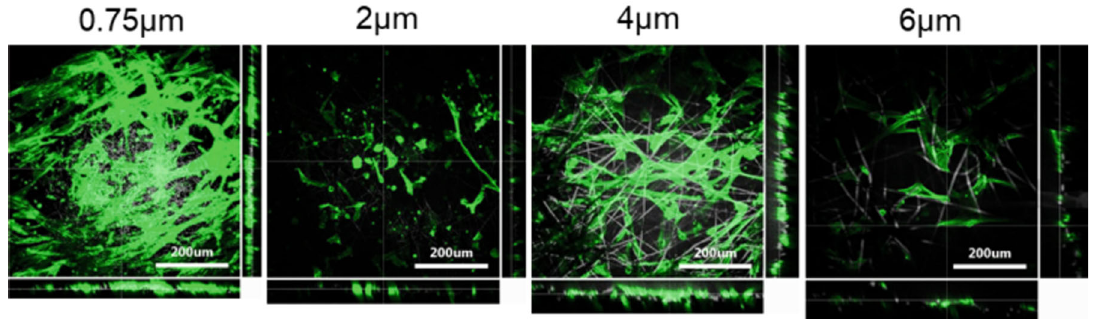
Fig. 4 Z-stack confocal fl uorescence images of actin stained HUVSMCs after 12 days of culture on all four scaffold morphologies. These images were used to deduce the quantity of cell in fi ltration